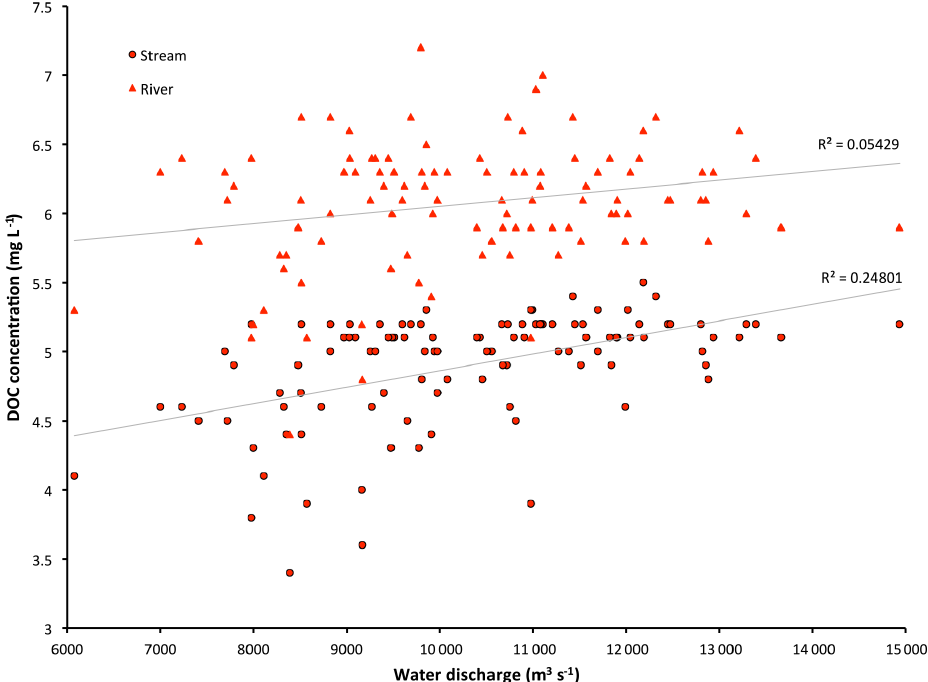
Figure 11. Simulated basin-mean annual DOC concentrations (mgL − 1 ) for the stream and river water pools regressed against mean annual simulated discharge rates (m 3 s − 1 ) at Kusur over 1901–2007. Linear regression plots with corresponding R 2 values are